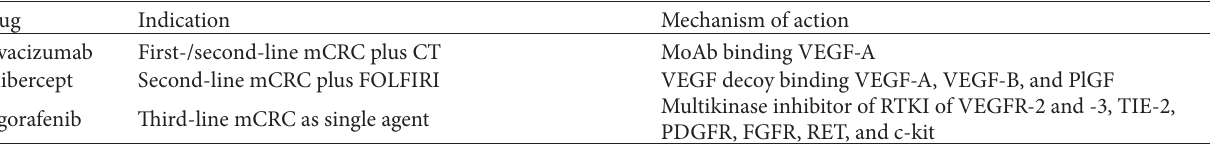
Table 1: Bevacizumab, aflibercept, and regorafenib are antiangiogenic drugs currently approved for mCRC treatment. These drugs have proved successful for the clinical treatment of various types of cancer and their mechanism of action results different affecting a variable range of cell types and signaling within tumor microenvironment.